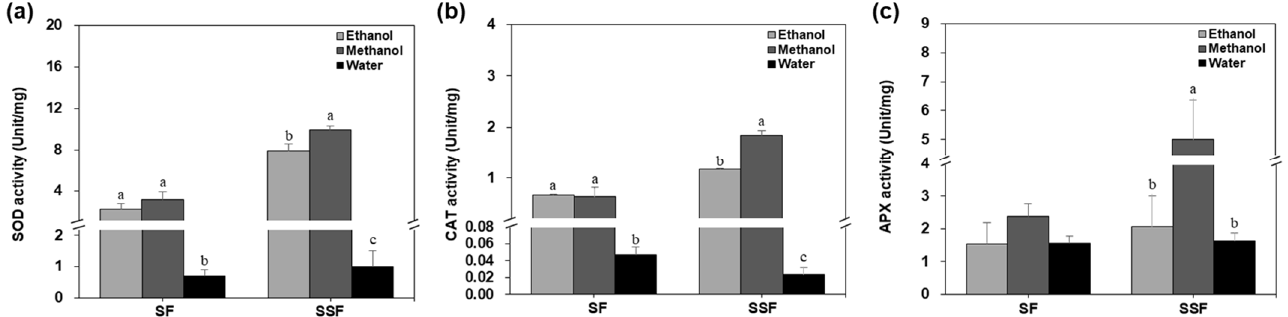
Figure 2. Antioxidant enzyme activities of fresh and steamed Sargassum fusiforme extracts. ( a ) SOD, ( b ) CAT, and ( c ) APX activity. SF: S. fusiforme extract, SSF: Steamed S. fusiforme extract. The different lowercase letters represent significant differences between solvents within the same sample ( p < 0.05).